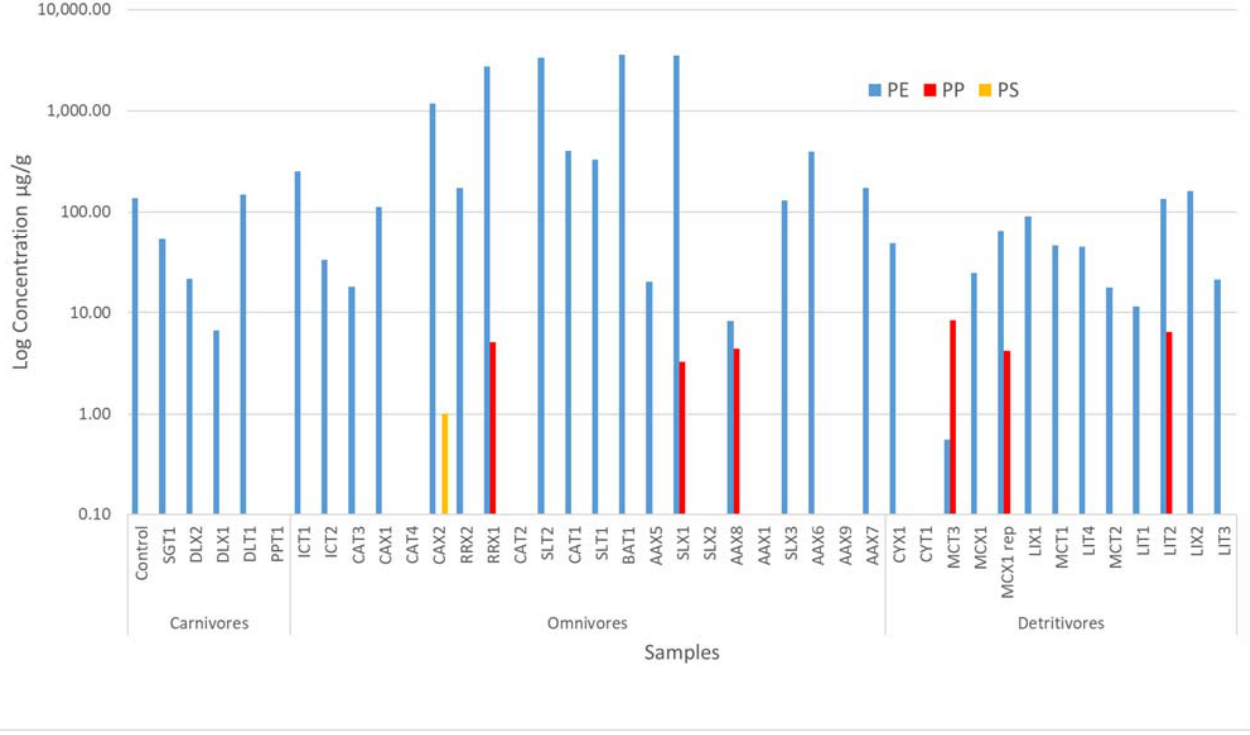
Figure 3. Concentrations of polymers in the samples expressed in equivalent concentrations of μ g/g.